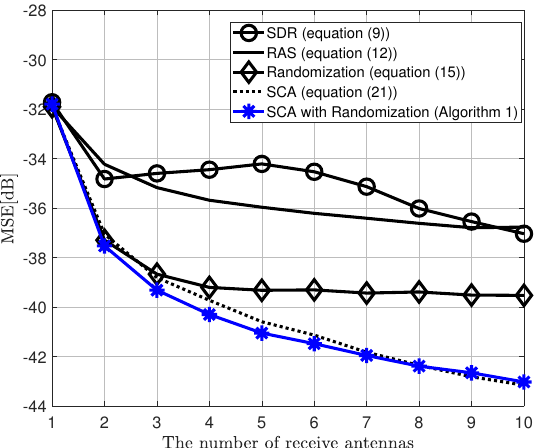
Figure 6. MSE performance of the proposed MIMO AirComp framework and other receive beamforming techniques, when SNR is 10 dB, objective function is arithmetic mean, and N T = 2, K =